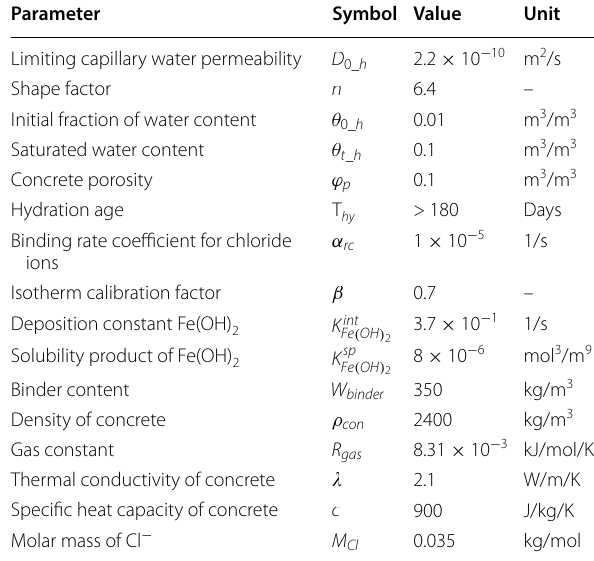
Table 2 Parameters included in the computational